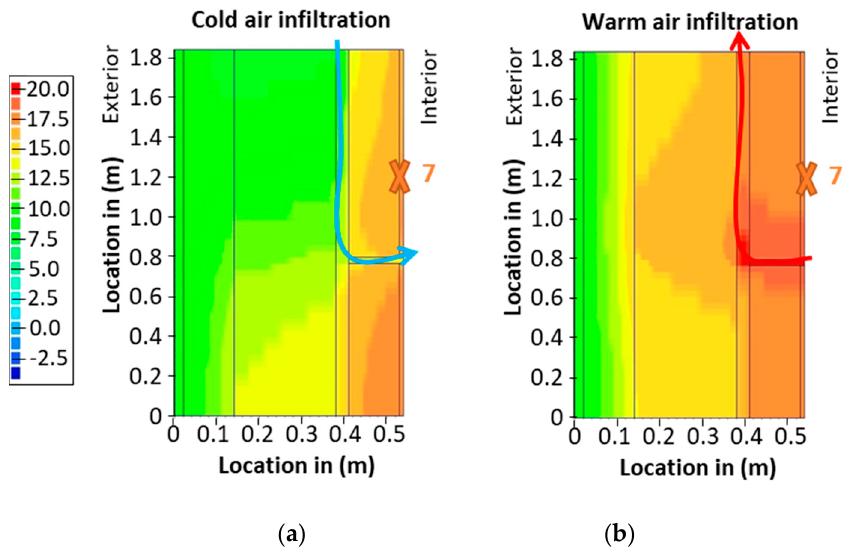
Figure 8. Simulation of the temperature variance for air cavity ventilation in the front facade. ( a ) Cold exterior air infiltrating in the cavity. ( b ) Warm interior air infiltrating in the cavity.